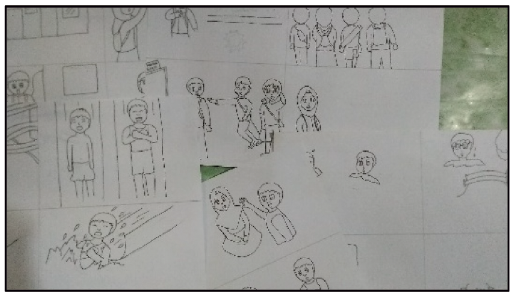
Figure 2. Manual drawing using pencil on drawing paper